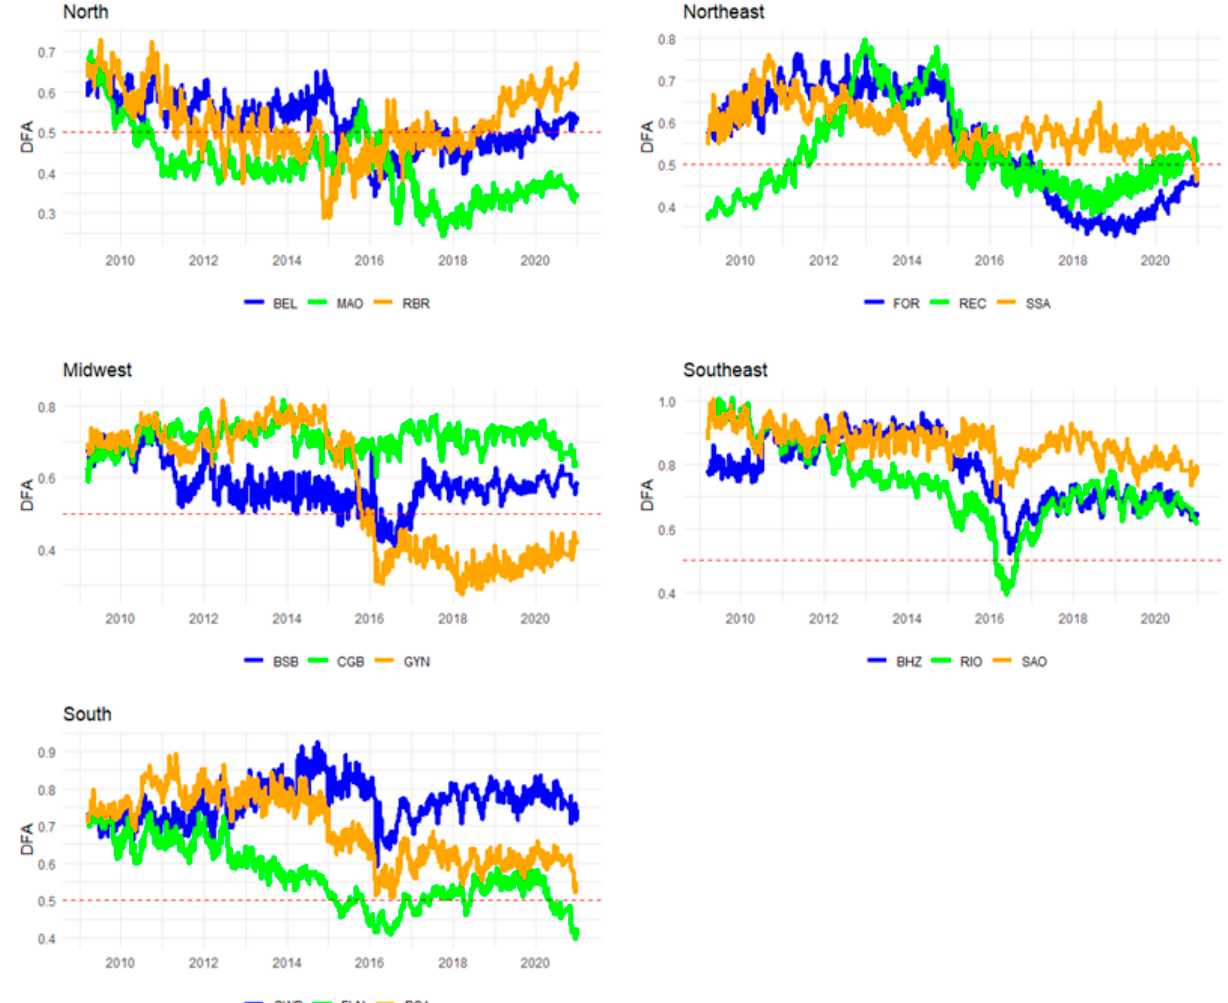
Figure 1. Persistence behavior (Hurst H exponent) in Brazilian capitals through the 250-day moving window. The dashed line (H = 0.5) represents the random walk.